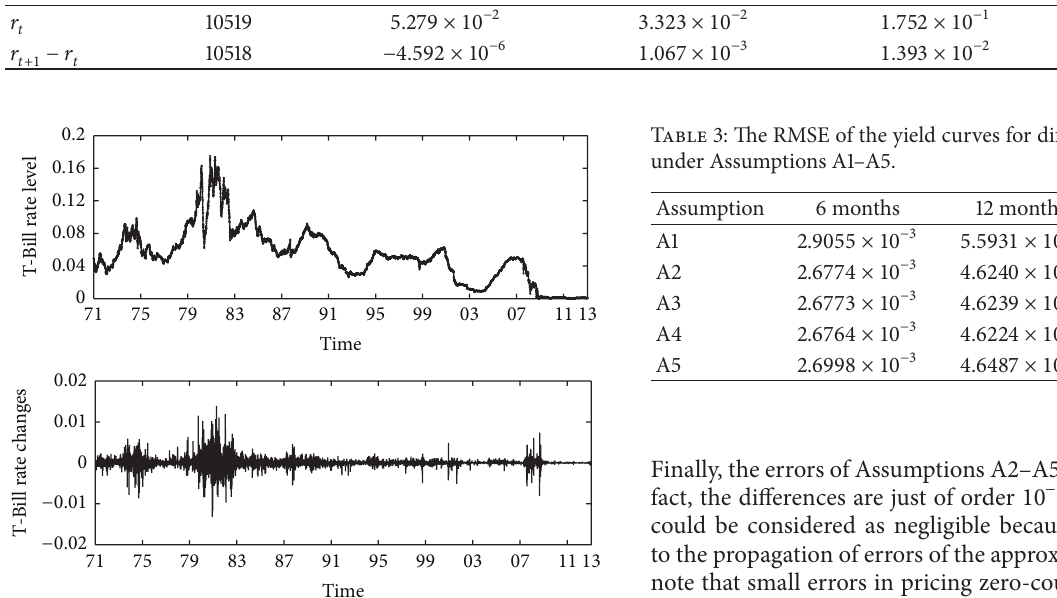
Table 2: Summary of the statistics of the US 3-month Treasury Bill rates and the first differences, January 1971 to February 2013. Variable